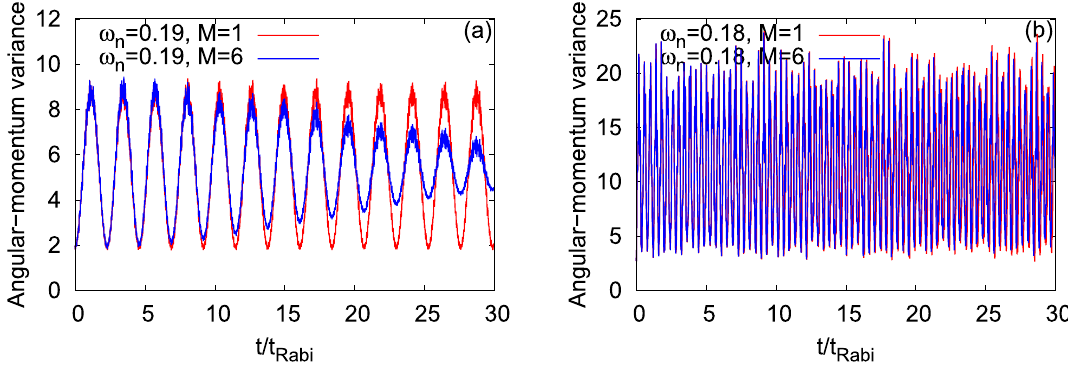
Figure 15. Time-dependent variance per particle of the z - component of the angular-momentum operator, 1 � 2 ( t ) , in a transversely-asymmetric 2D double-well potential for (cid:31) G (left column, ω n N L Z ˆ 0.18 ) under transversal resonant tunneling conditions. The number of bosons is N column, ω n = 0.01 π . M 1 signifies the mean-field results. The many-body dynamics are interaction parameter � = = 6 time-dependent orbitals. We show here dimensionless quantities. Color codes are computed with M = explained in each